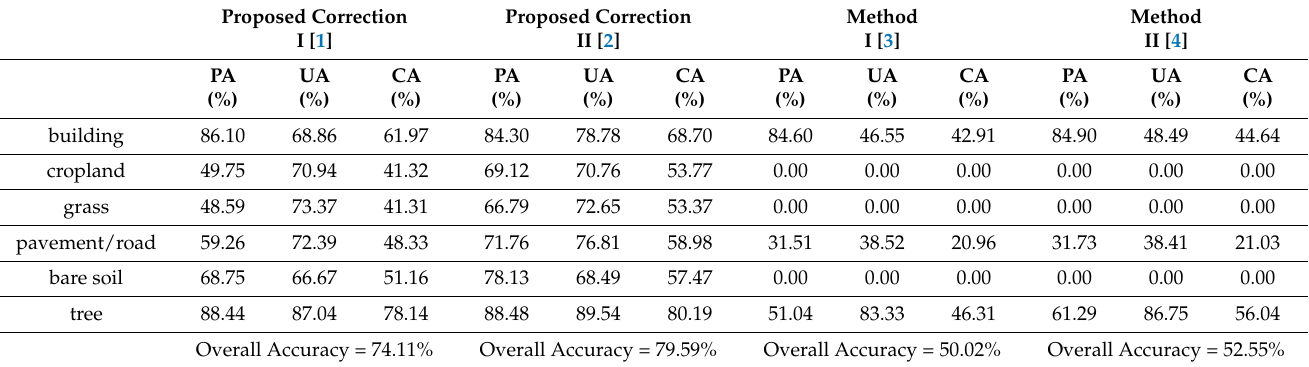
Table 5. The classification accuracy of the two methods during our study